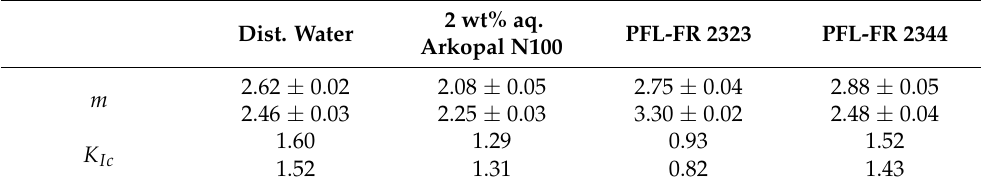
Table 4. Fitted exponents m for the two individual experiments per medium from power law behavior and critical stress intensity factor in MPa m 0.5 as a crucial value for transition from craze–crack propagation to macroscopic plastic